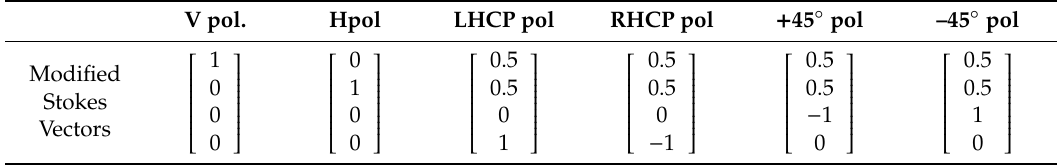
Table 1. Modified Stokes vectors for di ff erent